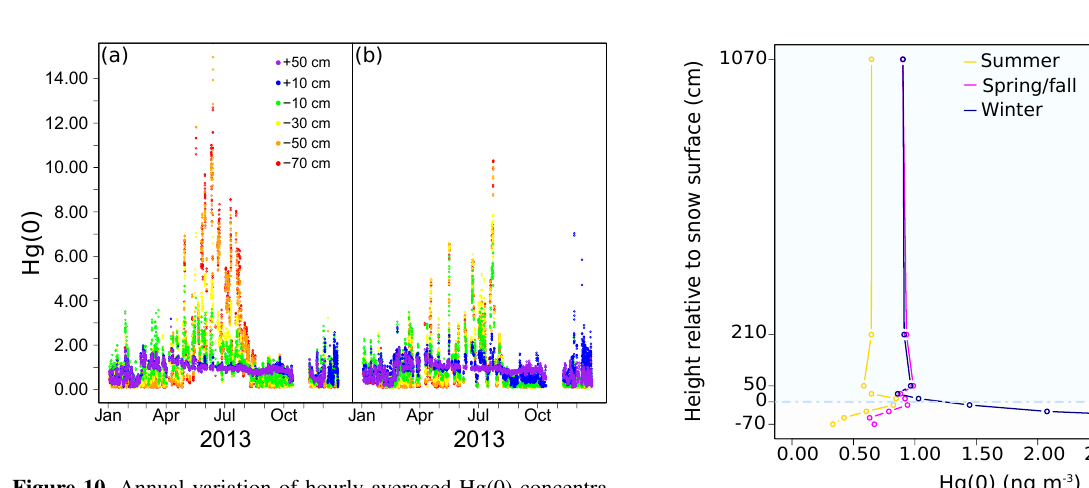
Figure 10. Annual variation of hourly averaged Hg(0) concentra- tions (in ngm − 3 ) in the snow interstitial air collected at the various inlets of the two snow towers: (a) snow tower #1, (b) snow tower #2. Note that we regularly experienced technical problems on snow tower #2 leading to missing values.